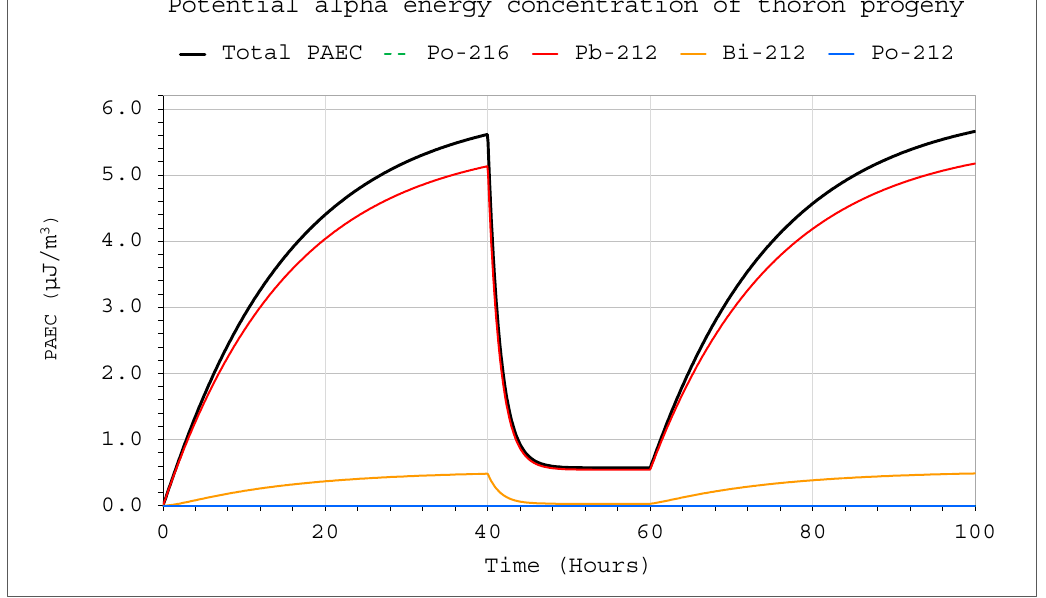
Figure 12. Potential alpha energy concentration of thoron progeny inside the system for the following conditions: inflow of thoron throughout the analyzed period at a rate of E 1 = 1 Bq/s, V = 1 m 3 , C oi = 0. The filtration system was operating in a range of 40–60 h with a flow rate of Q D = 10 L/min and filtration efficiency of F = 100%.